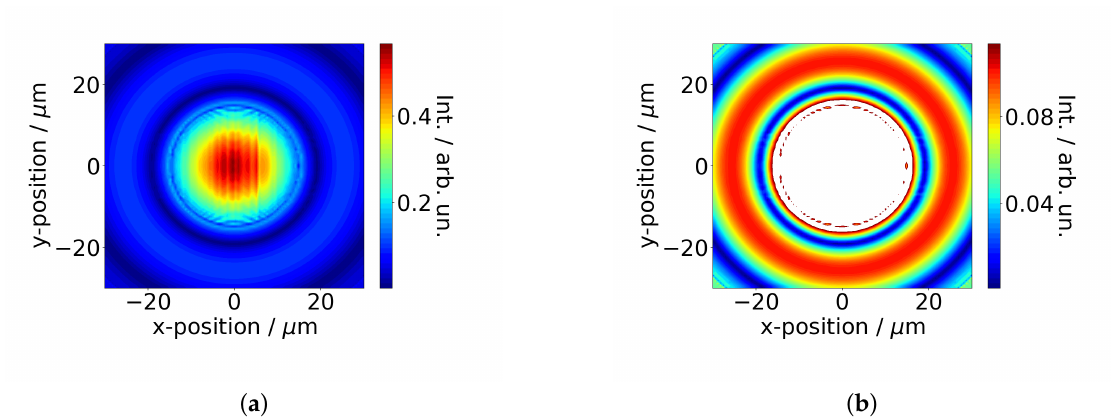
Figure 4. Simulated near field distribution of the reflected light at 500nm distance from the surface. Two different color scales are used to show that fringes are visible only in the central part ( a ) and not in the Airy ring ( b ).